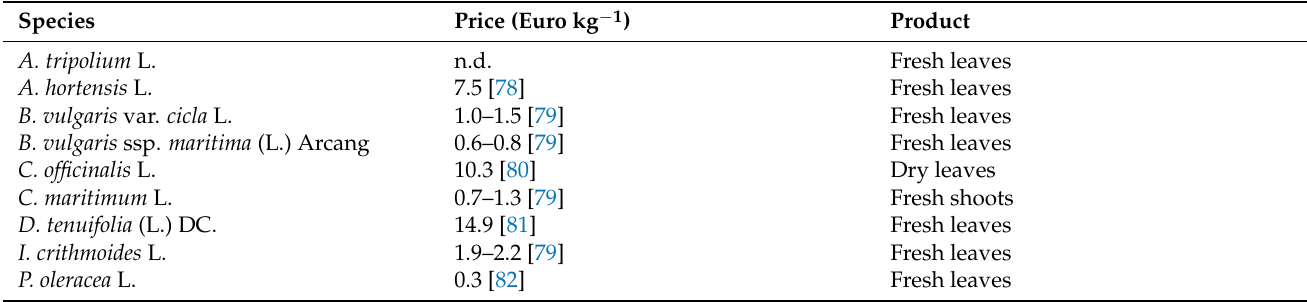
Table 7. Selling price of the considered plant